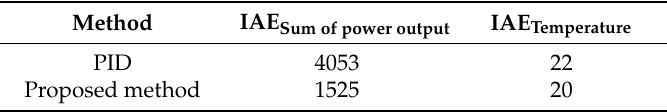
Figure 17. Case 3: Tracking performance on time-varying power load demands (Solid in blue: proposed method; dot-dashed in red: PID; dot in green: reference). ( a ) Sum of power output; ( b , c ) Output variables; ( d , e ) Manipulated variables. Table 4. Performance indices for Figure 17.